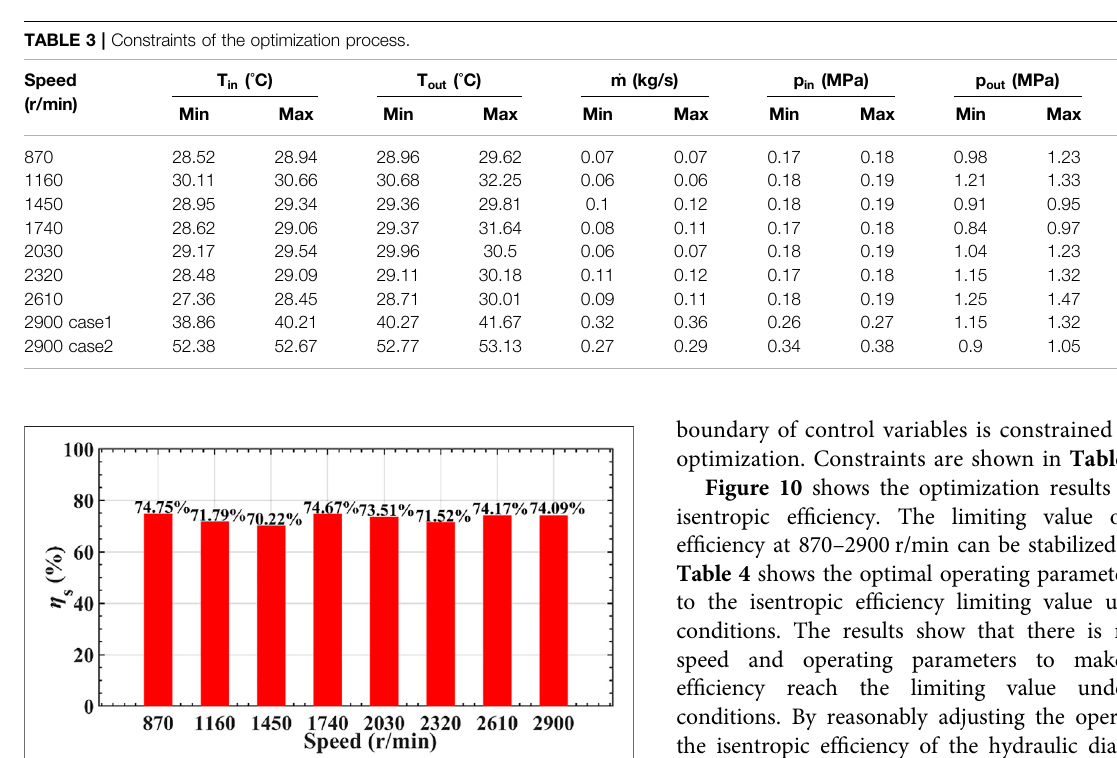
FIGURE 10 | Optimization results under all working